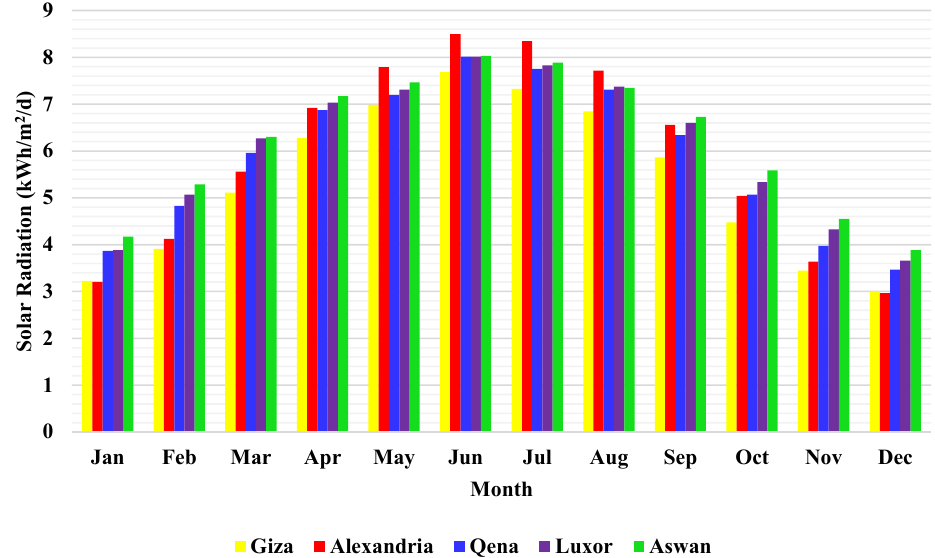
Figure 4. The average monthly solar radiation data in Giza, Alexandria, Qena, Luxor and Aswan.